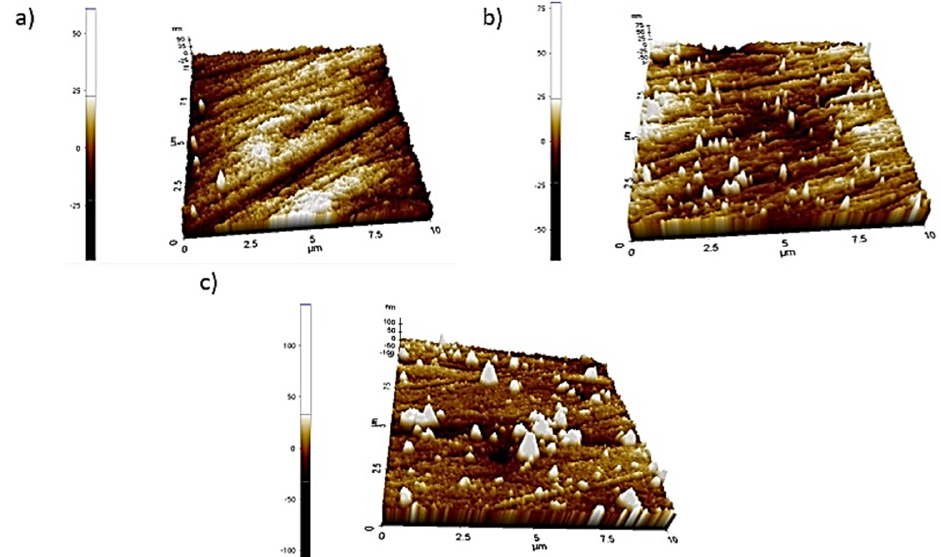
Figure 3. AFM 3D representation of surface topography images of the ZnO thin film deposited after ( a ) 500, ( b ) 1000, and ( c ) 1500 cycles.